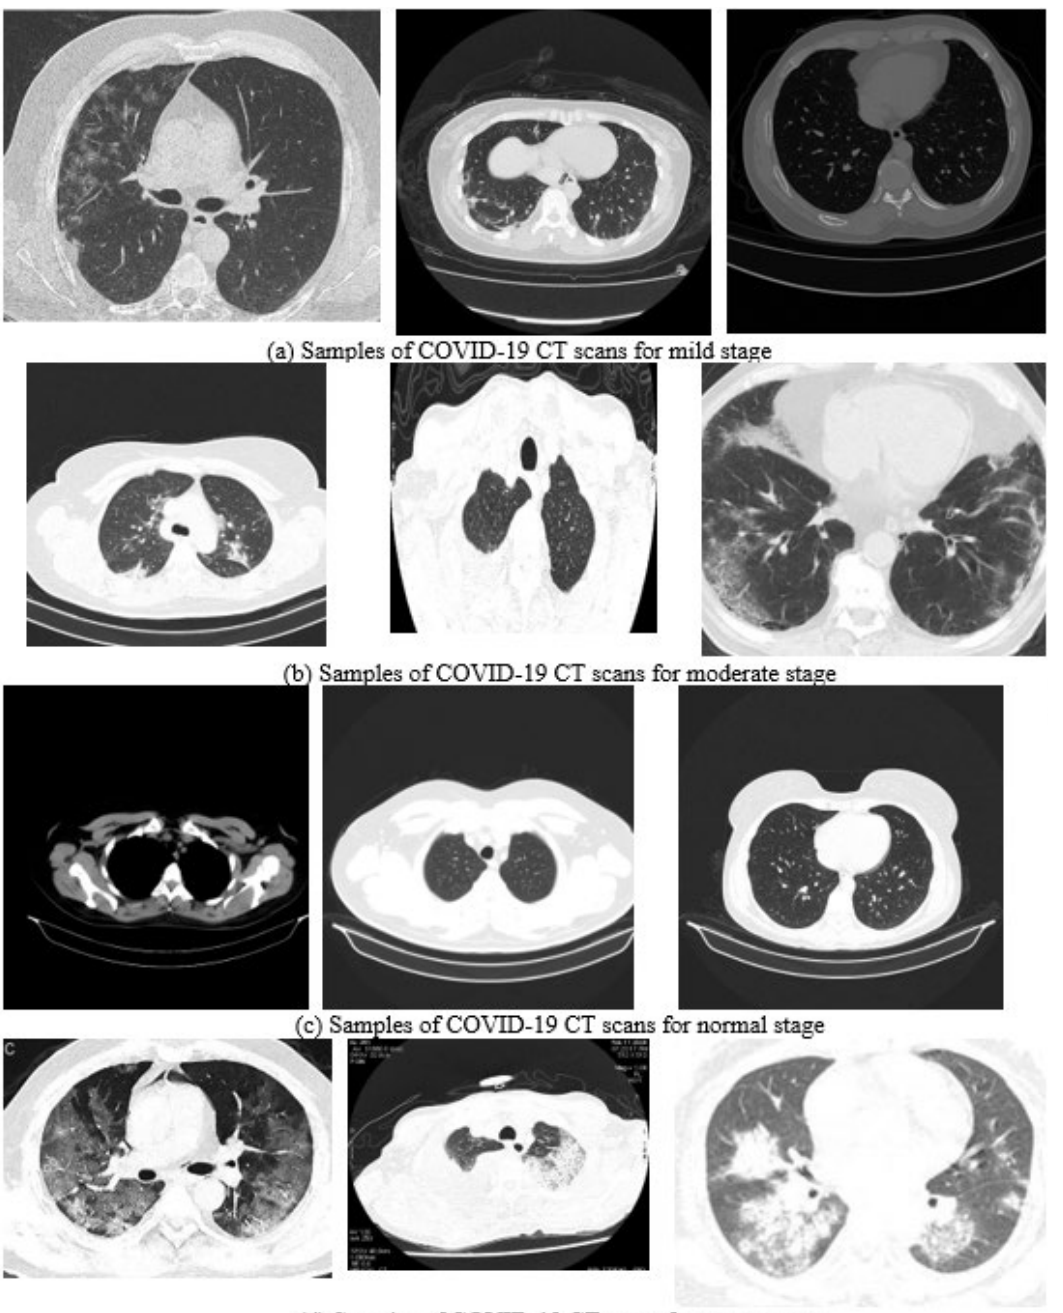
Figure 3. The diversity of the dataset.